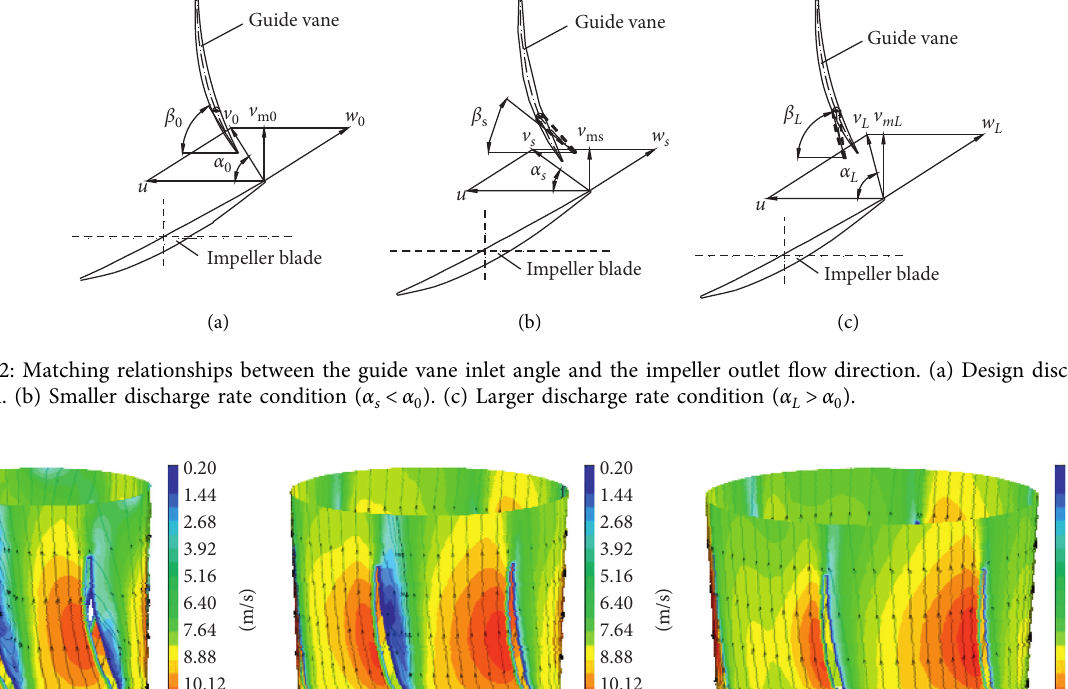
Figure 13: Flow fields of the three tori of the guide vane ( Δ β � 0 ° ). (a) Inner torus. (b) Middle torus. (c) Outer torus.